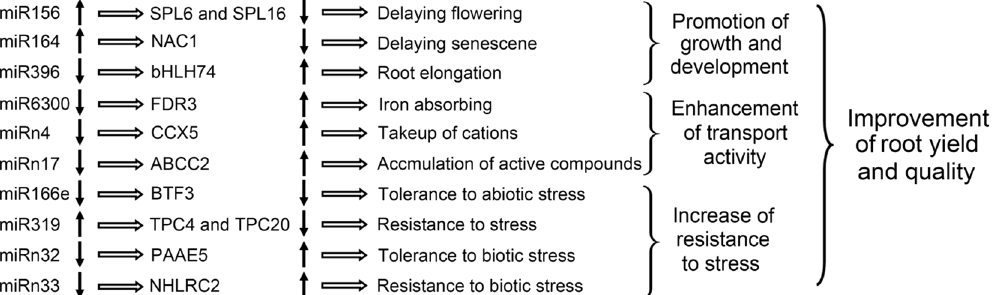
Figure 8. A hypothetical regulatory mechanism of DE miRNA-target modules involved in the replanting benefit of A. bidentata roots. ↑ : upregulation of expression; ↓ : downregulation of